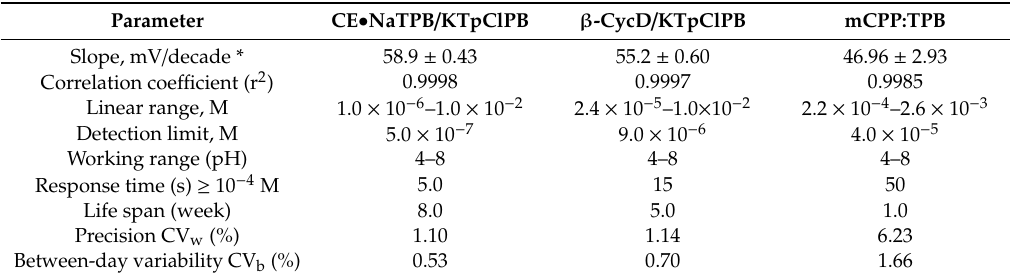
Table 1. Potentiometric performance characteristics of m-chlorophenylpiperazine polymeric membrane based selective